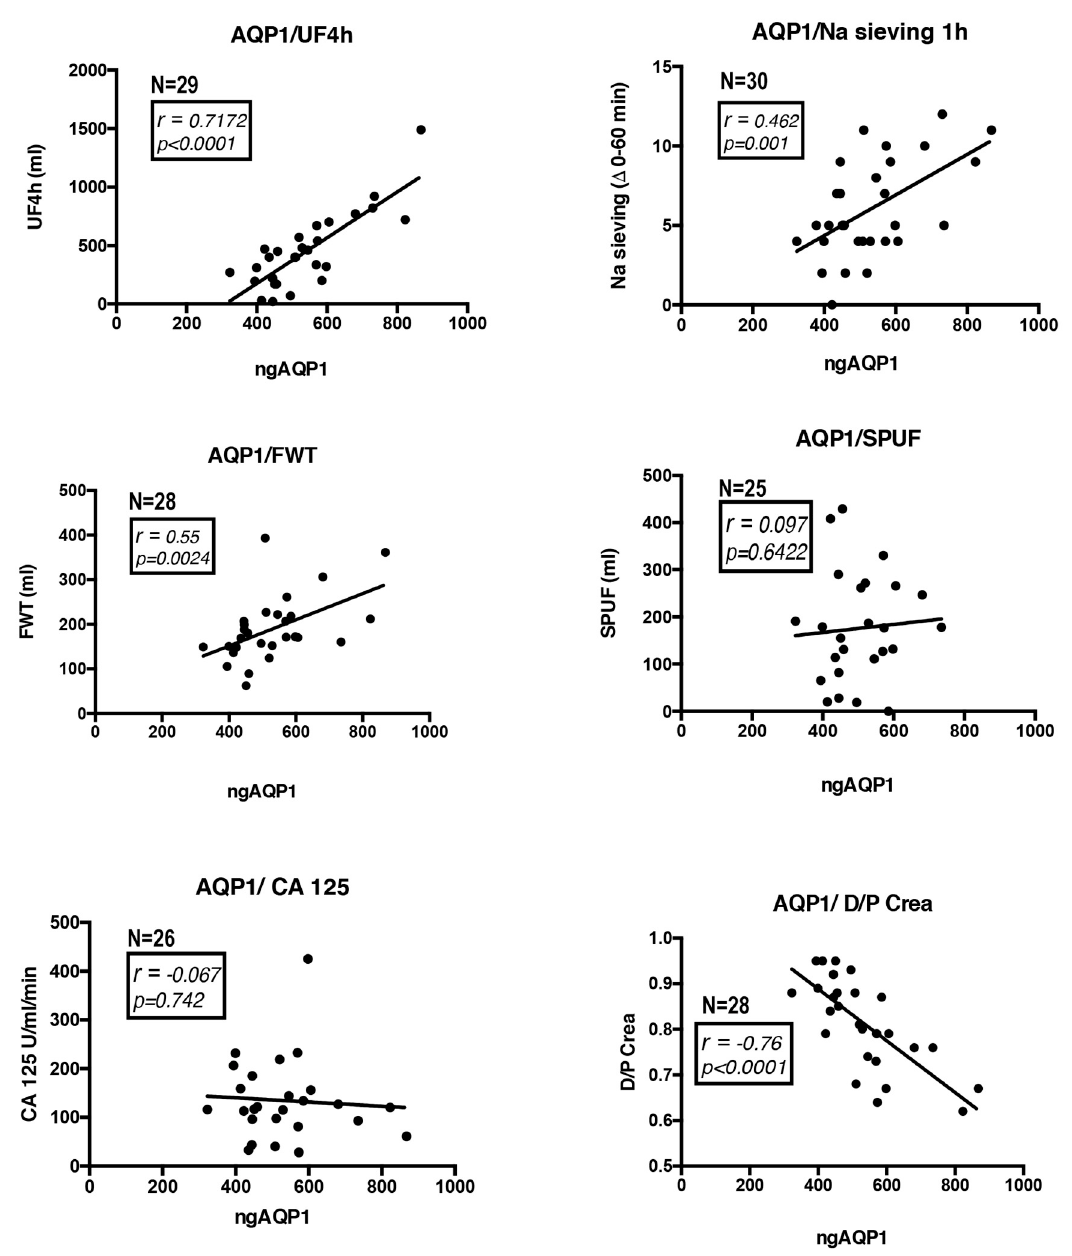
Figure 4. AQP1 was quantified in PD effluent samples from patients undergoing a 4-h, 3.86% glucose PET. AQP1 abundance, which was expressed as the amount of AQP1 in nanograms in the total volume (ngAQP1) of PD effluent drained at the end of the PET test, was correlated with ultrafiltration (UF), sodium (Na) sieving, free water transport (FWT), small-pore ultrafiltration (SPUF), Cancer Antigen 125 (CA125) and the dialysate-to-plasma ratios of creatinine (D/P Crea). Correlation analysis was performed assuming non-Gaussian distribution of the data and calculating nonparametric Spearman correlations. The number of patients analyzed (N) is indicated in each panel.